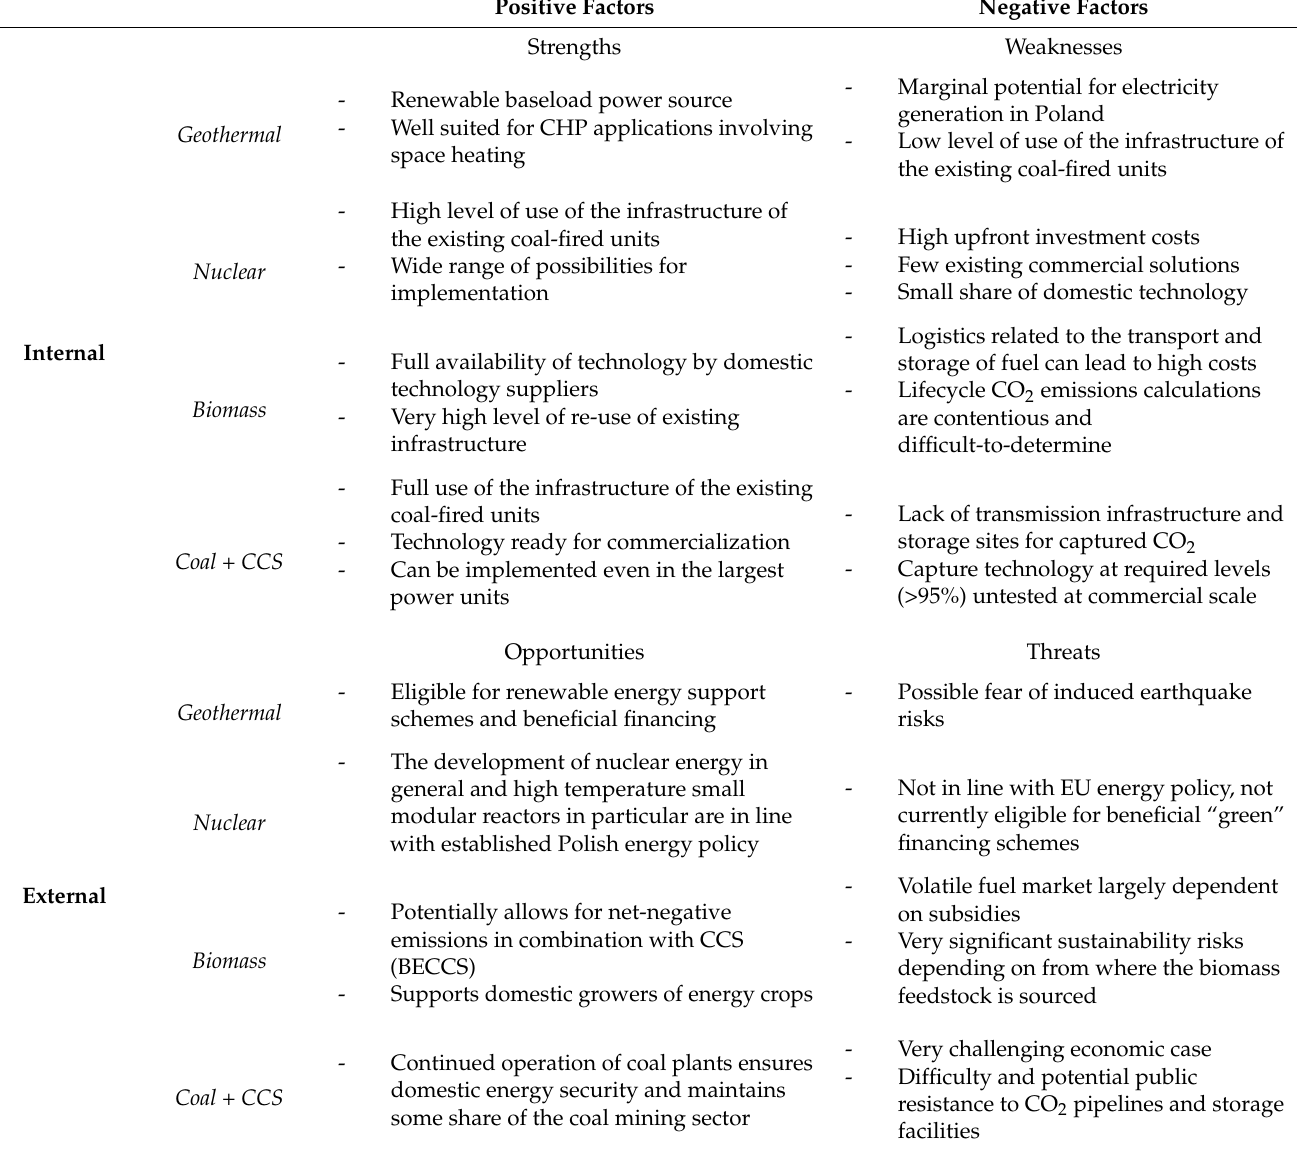
Table 11. SWOT-analysis of retrofit decarbonization